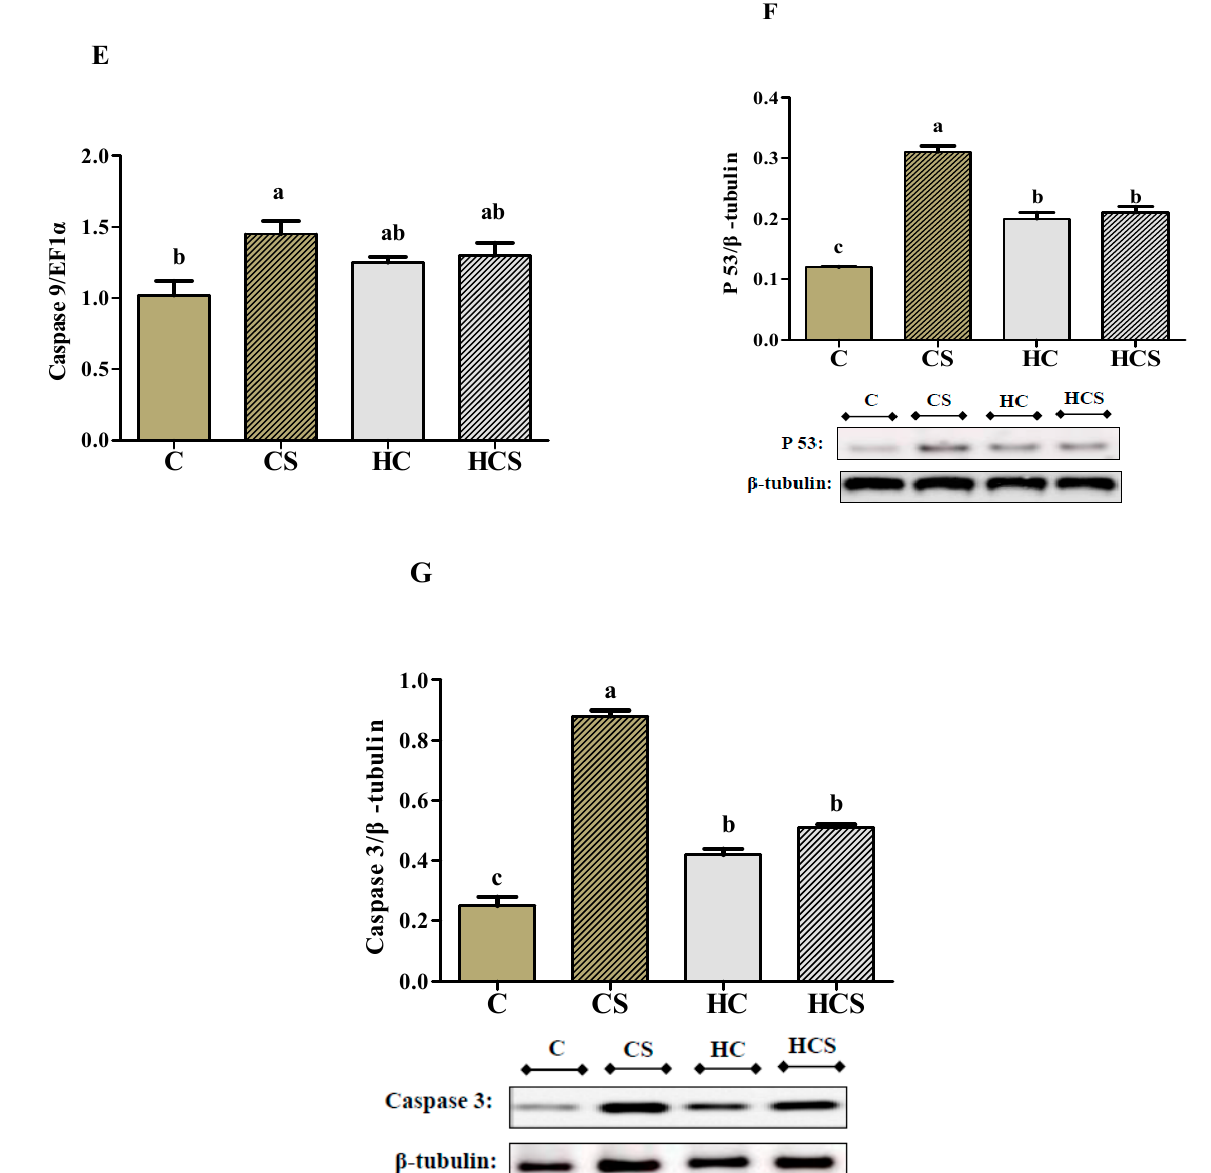
Figure 7. Hepatic transcriptional levels of apoptosis-related genes ( A : P 53; B : Bcl 2; C : Bax; D : Caspase 3 and E : Caspase 9) and protein ( F : P 53 and G : Caspase 3) of M. amblycephala subjected to different treatments. Gels were loaded with 20 mg total protein per lane. Each data point represents the means ± SEM of four replicates. Bars assigned different superscripts (a, b, c and d) are significantly different ( p < 0.05).